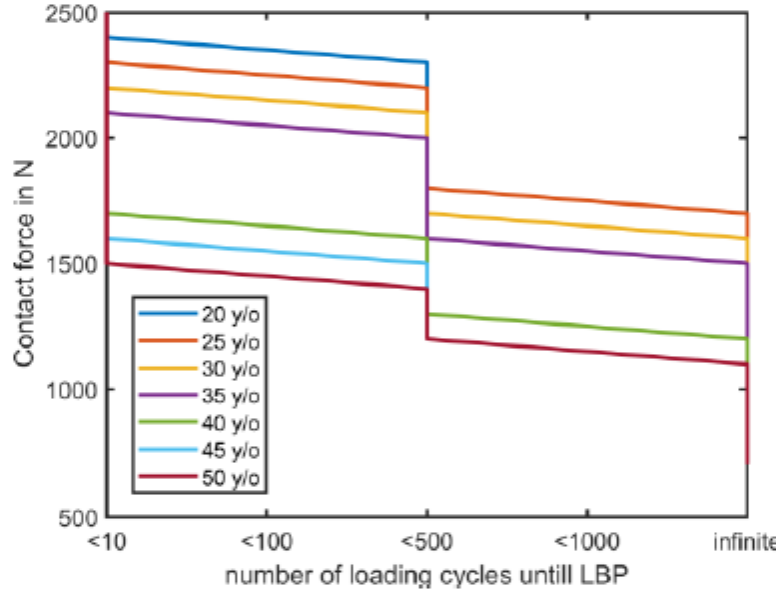
Figure 7. Maximal number of loading cycles prior to lower-back pain (LBP) based on the L5 contact force for different workers of different